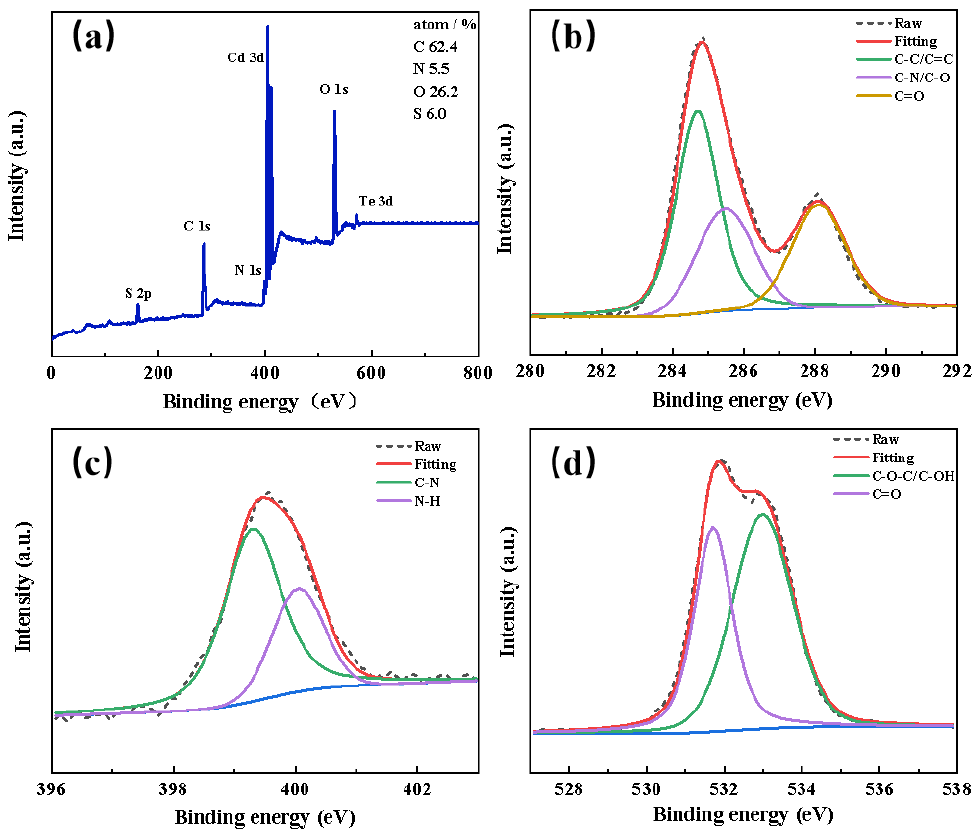
Figure 4. XPS spectra of GMPA@CdTe QDs, where ( a ) corresponds to full spectrum scan and ( b – d ) correspond to deconvoluted C1s, N1s, and O1s core-level spectra, respectively.